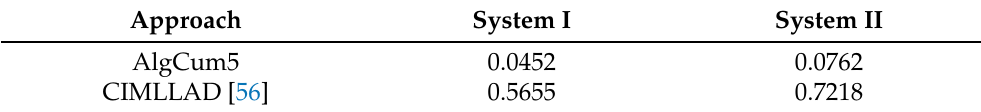
Table 2. MSE of different approaches.